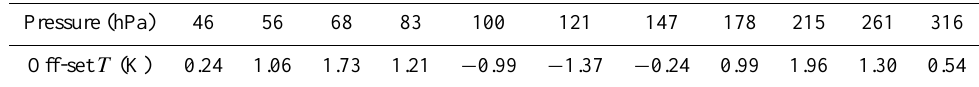
Table 1. Offset temperature obtained by comparison with GPS data at each MLS pressure